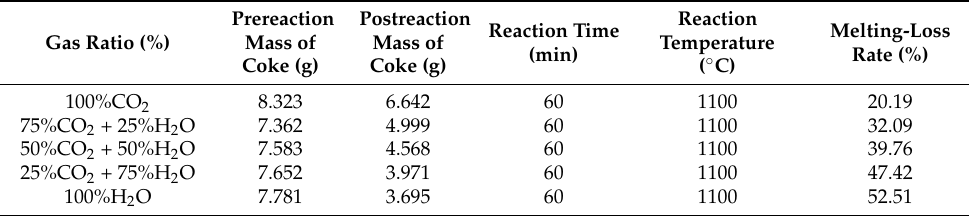
Table 3. Melting-loss rate of coke under different proportions of CO 2 and H 2